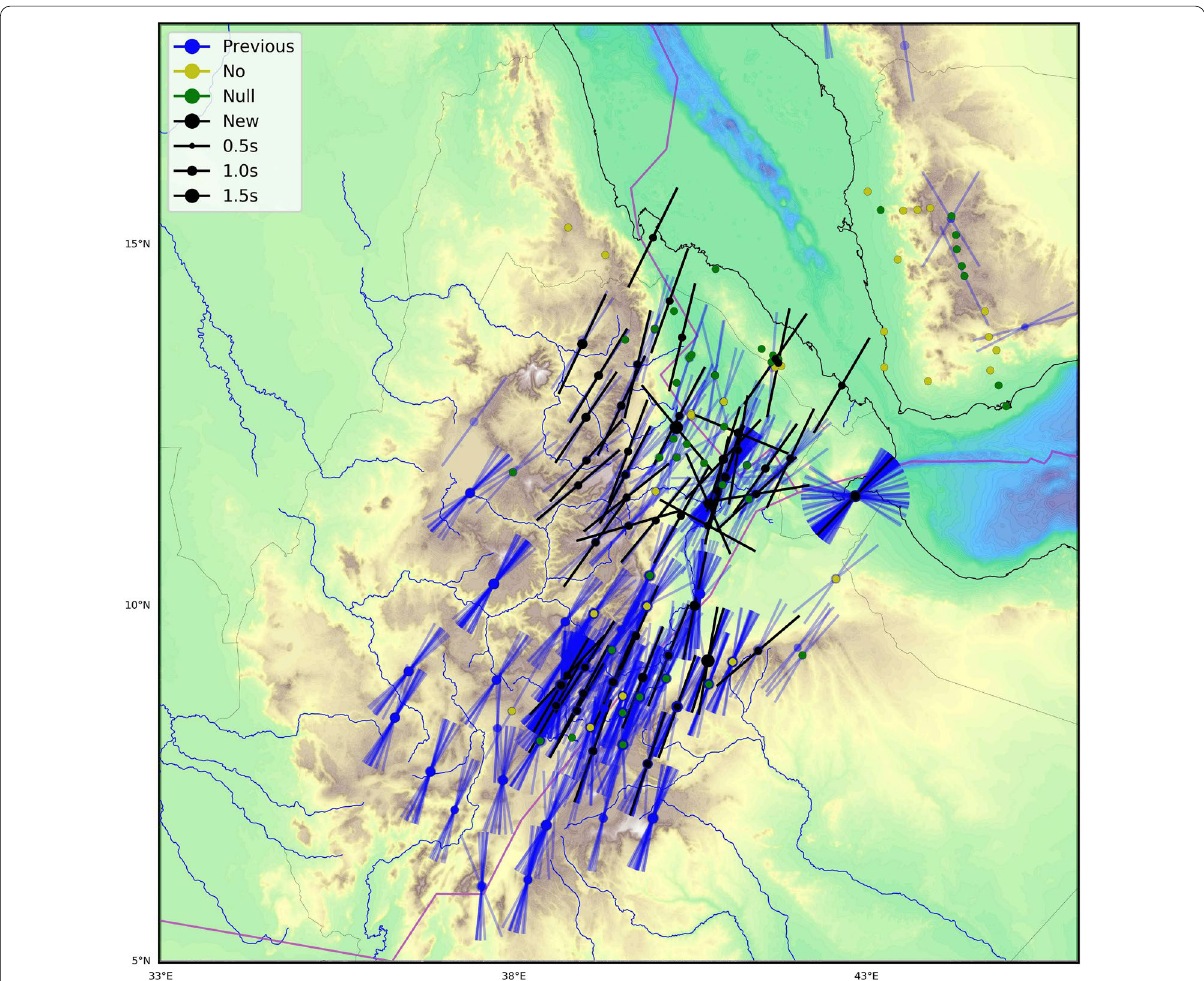
Fig. 12 Shear-wave splitting results for the broadband stations around the Afar triple junction. Blue: previous measurements available from international databases (Wüstefeld et al. 2009; IRIS 2012). Yellow: due to the data quality, no convincing measurements could be obtained. Green: null measurements. Black: each line indicates the mean fast polarization direction given by the median of all observations at one station. The circle size is proportional to the delay